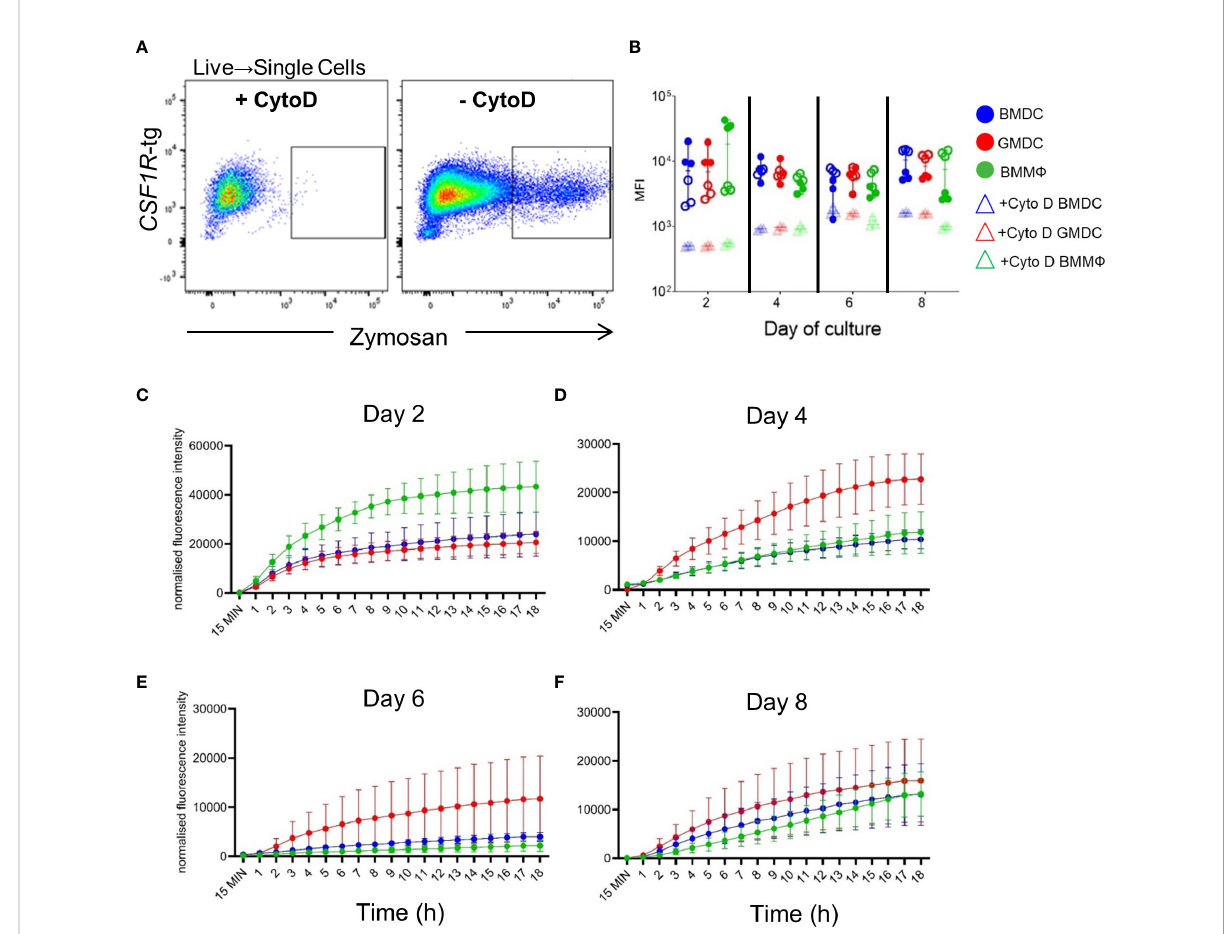
FIGURE 5 Real-time kinetics of uptake and phagosomal acidi fi cation using pHrodo labelled zymosan bioparticles. (A) Representative fl ow plots of the gating strategy. Gates were applied to the cells treated with the actin polymerization inhibitor, Cytochalasin D (CytoD), as negative controls. (B) MFI of zymosan in CytoD treated (rectangle) or untreated (circles) BMDC (blue), GMDC (red) and BMM F (green) on days 2, 4, 6 and 8 of culture by fl ow cytometry. Data represents the median (± range). From each bird (n=6), BMDC, GMDC and BMM F were generated. Data represents two independent experiments (n=3 per experiment, open & closed circles). (C – F) Real time kinetics of BMDC, GMDC and BMM F phagosomal acidi fi cation 15 min, and at every hour up to 18 h post-treatment with zymosan bioparticles. Data are represented as mean ( ± SD) of three biological replicates normalized to background fl uorescence of cells treated with